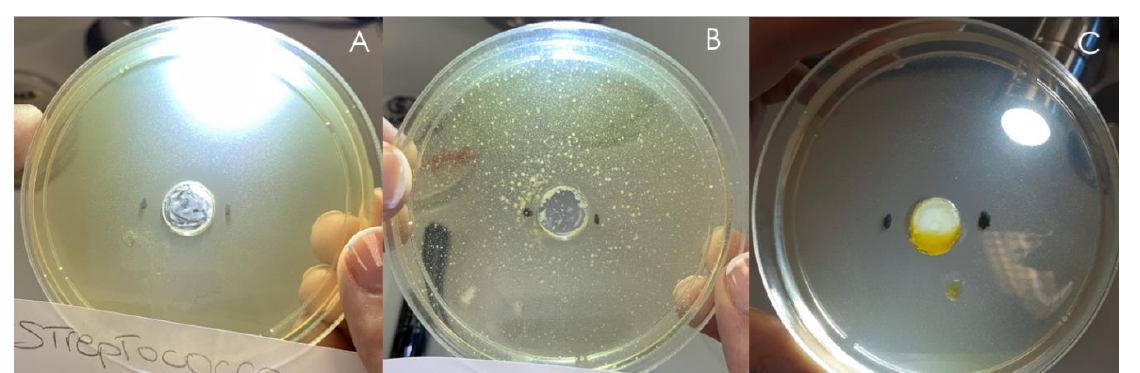
Figure 5. Inhibition halos measured for D.E. ( A ) S. pyogenes ( B ) S. aureus ; for L.E. S. pyogenes ( C ).